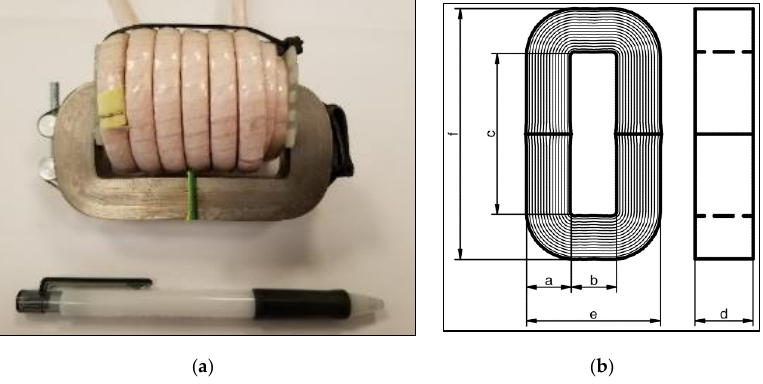
Figure 9. ( a ) Inductor prototype; ( b ) Dimensions of AMCC50 core: core build a = 16 mm; window width b = 20 mm; window length c = 70 mm; core height d = 25 mm; core width e = 52 mm; core length